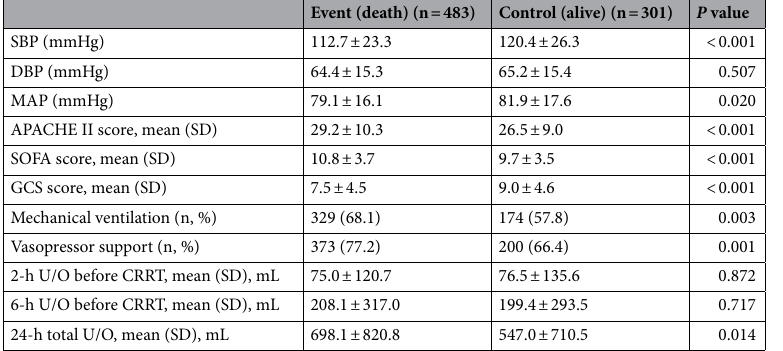
Table 2. Clinical parameters at the time of CRRT initiation. Continuous variables are presented as means (standard deviations), and categorical variables are presented as frequencies (percentages). SBP systolic blood pressure, DBP diastolic blood pressure, MAP mean arterial pressure, APACHE II acute physiology and chronic health evaluation II, SOFA sequential organ failure assessment, GCS glasgow coma scale, CRRT continuous renal replacement therapy, U/O urinary output, SD standard deviation.